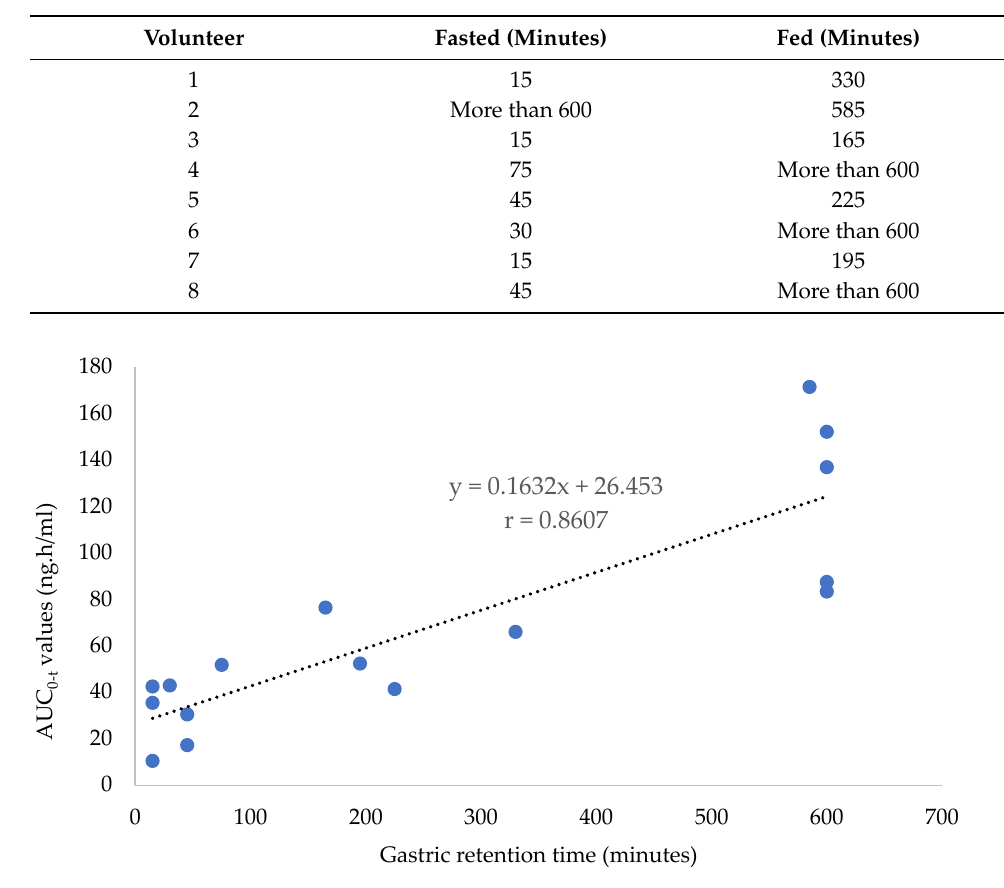
Table 5. Gastric retention time for thiamine floating tablets in healthy volunteers in fasted and fed states.